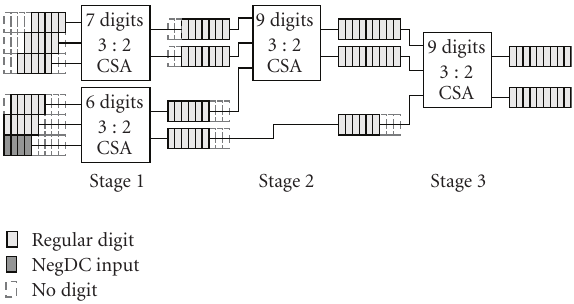
Figure 8: Example: CSA Tree for 6 input